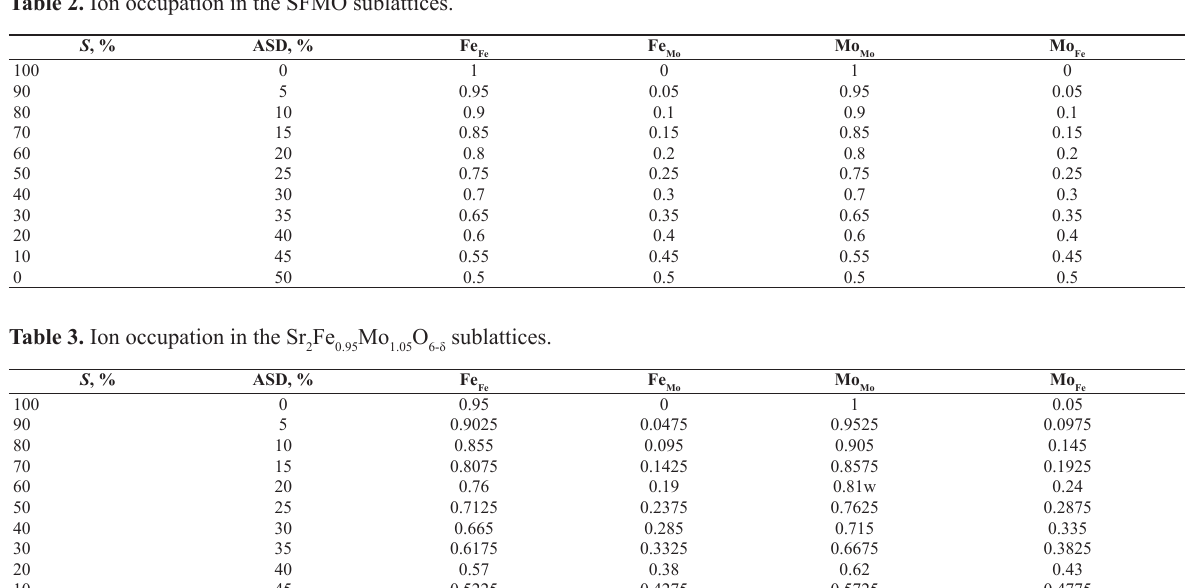
Fe Mo O and ( 5 ) calculation using Eq. 2 1.05 0.95 6-δ